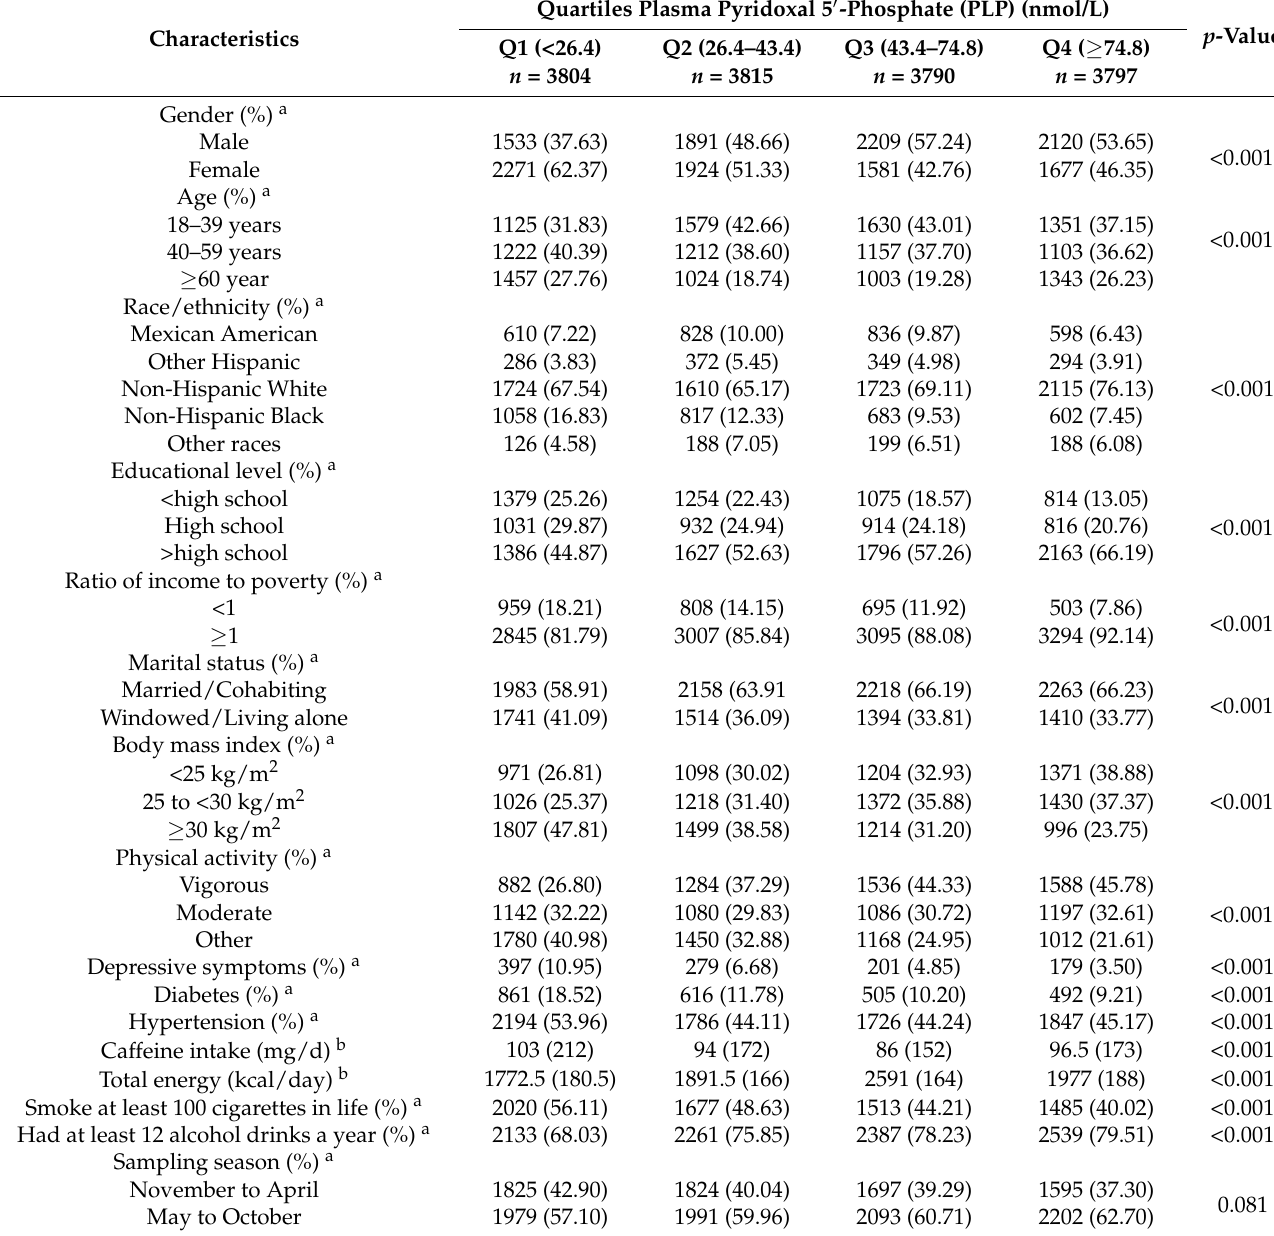
Table 1. Baseline characteristics of participants by quartile of pyridoxal 5 (cid:48) -phosphate (PLP) (NHANES